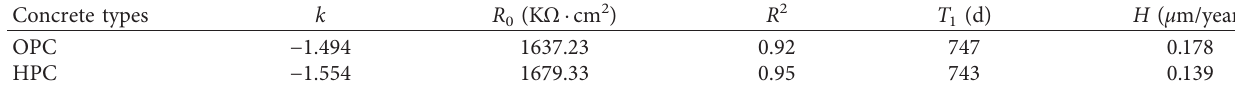
Table 2: The corrosion time and corrosion rate of OPC and HPC.